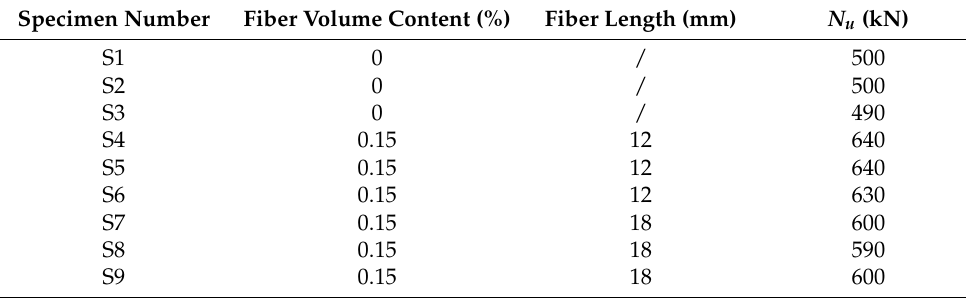
Table 5. The axial compression test results of the BRFC short columns.